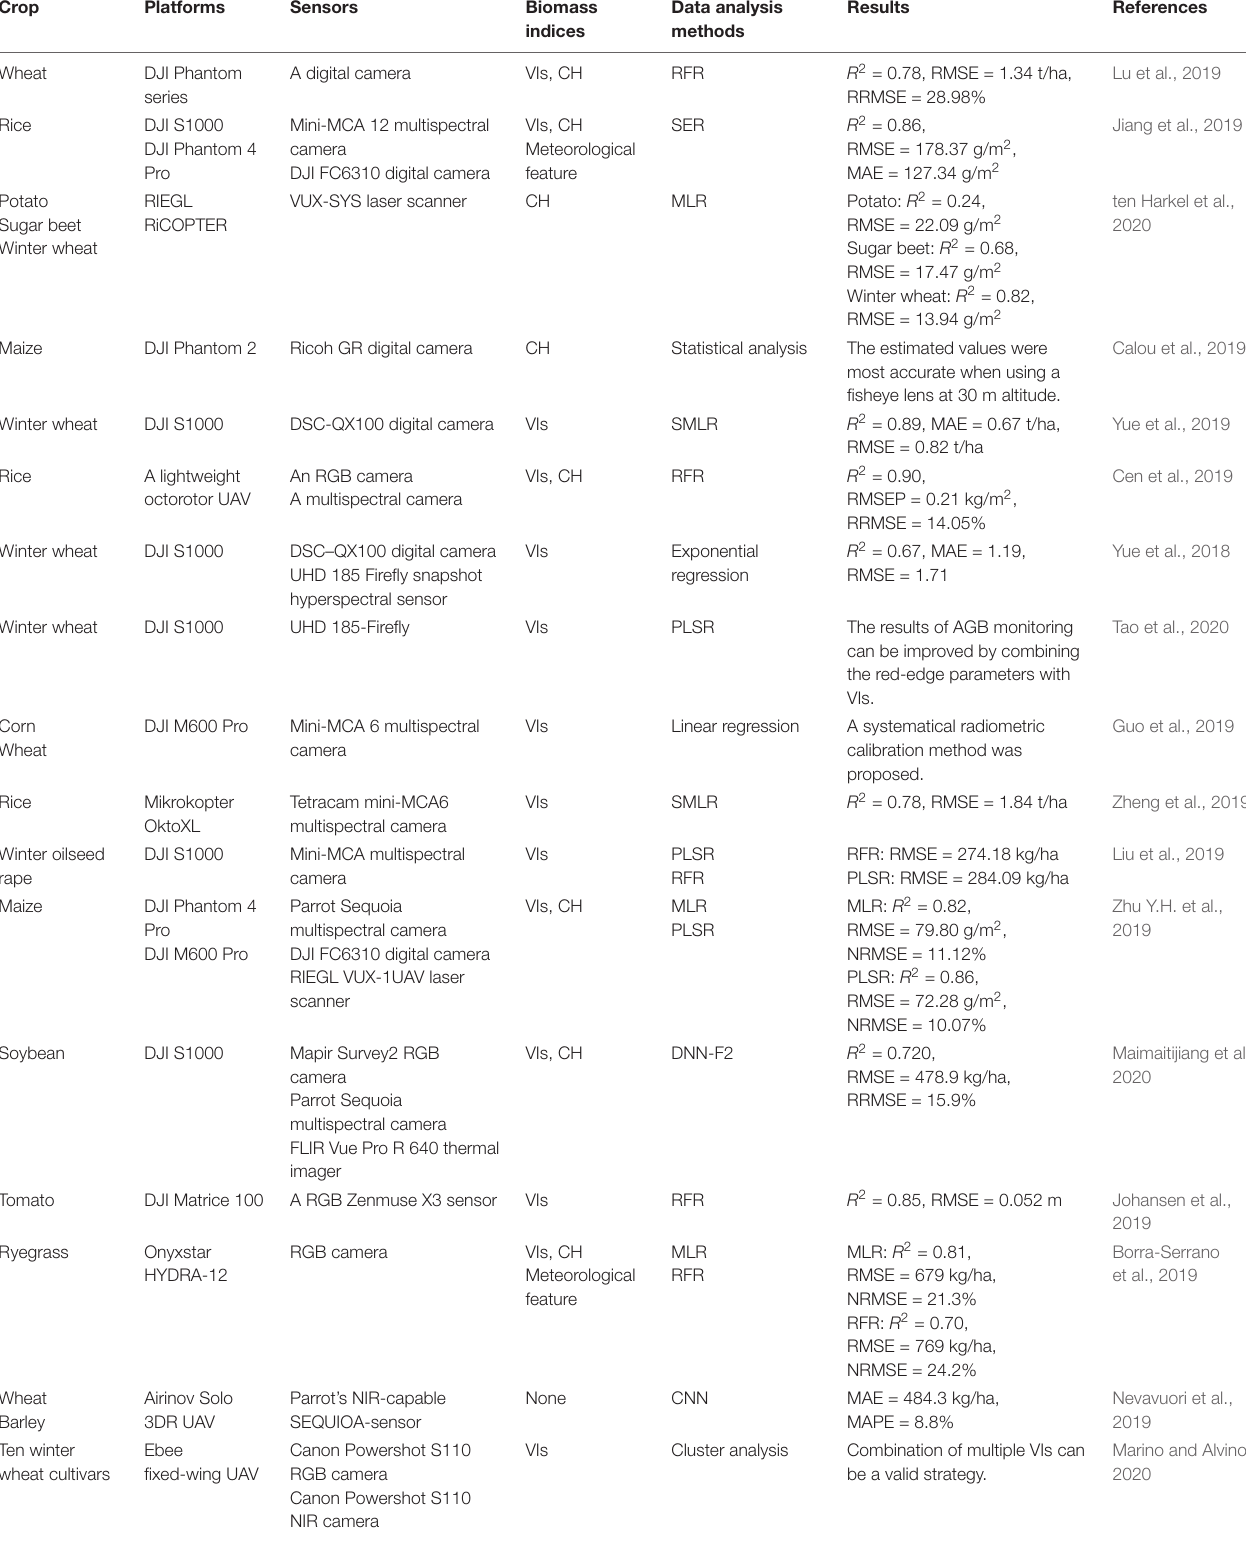
TABLE 2 | Summarize the equipment, methods, and important results of the studies cited in the